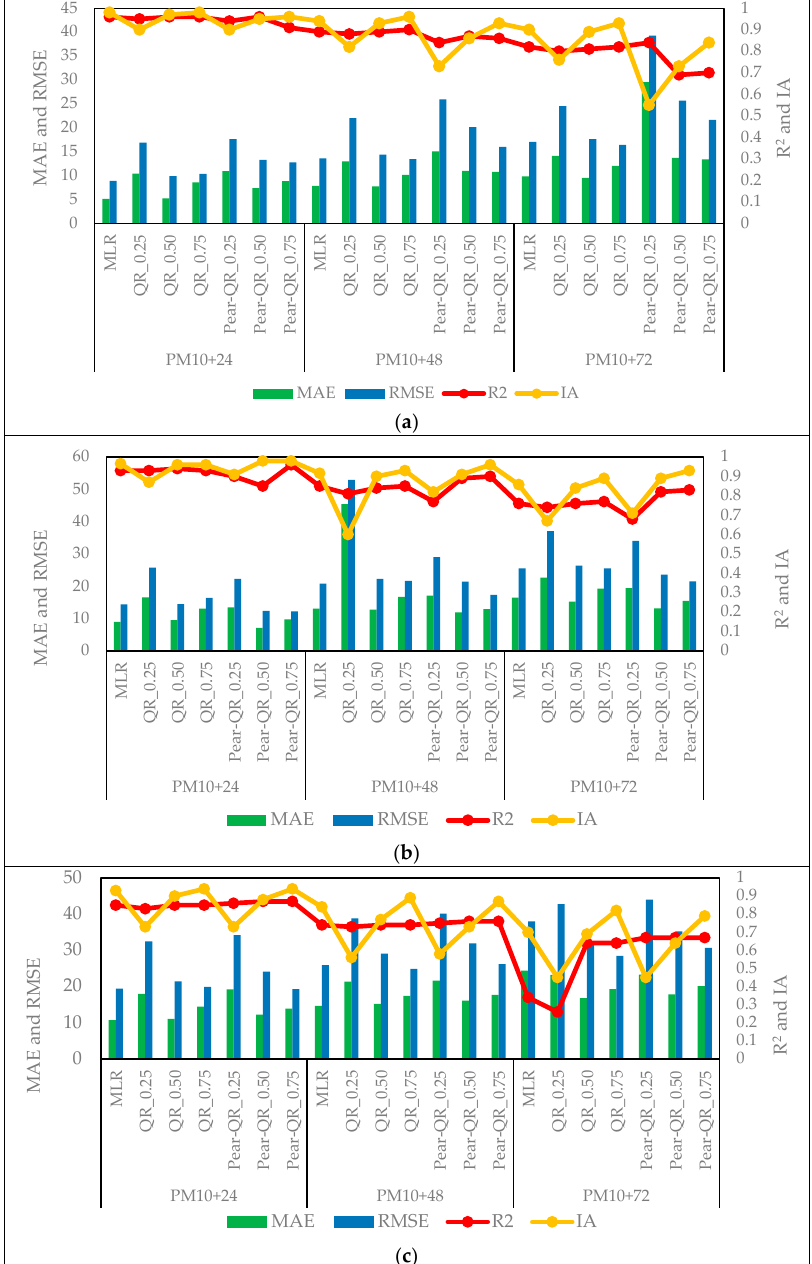
Figure 7. Performance measures for prediction of the next-day (PM10+24), the next two days (PM10+48), and the next three days (PM10+72) in ( a ) Pasir Gudang, ( b ) Melaka, and ( c ) Petaling Jaya. MLR is multiple linear regression; QR_0.25 is quantile regression at p = 0.25; QR_0.50 is quantile regression at p = 0.50; QR_0.75 is quantile regression at p = 0.75; Pear-QR_0.25 is Pearson–quantile regression at p = 0.25; Pear-QR_0.50 is Pearson–quantile regression at p = 0.50; Pear-QR_0.75 is Pearson–quantile regression at p = 0.75.